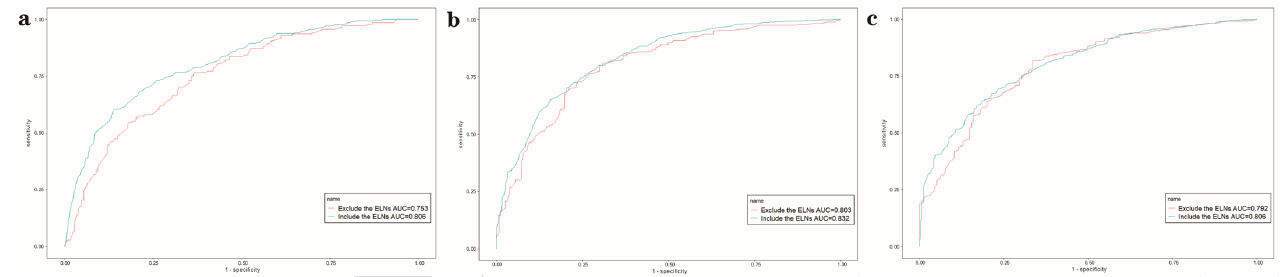
Figure 7. The area under the receiver operating characteristic curve (AUROC) of the XGBoost model for predicting 1 − ( a ), 3 − ( b ), and 5 ( c ) − year overall survival with or without the optimal for predicting 1- ( a ), 3- ( b ), and 5- ( c ) year overall survival with or without the optimal number number (n = 32) of examined lymph nodes (ELNs). (n = 32) of examined lymph nodes